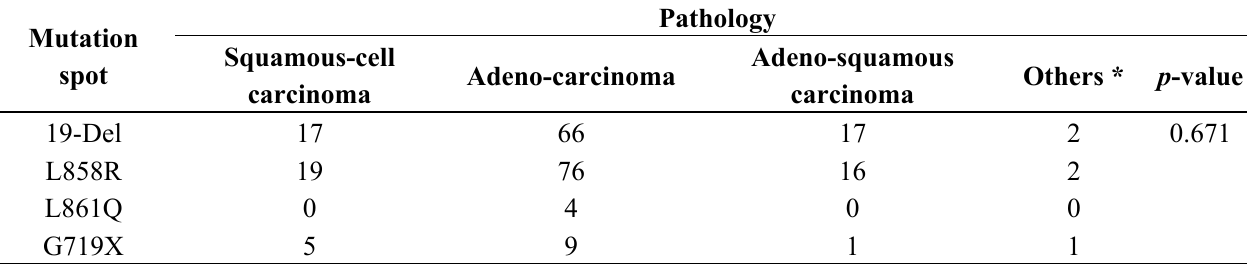
Table 4. Subtypes of TKIs sensitive EGFR mutation according to histology.